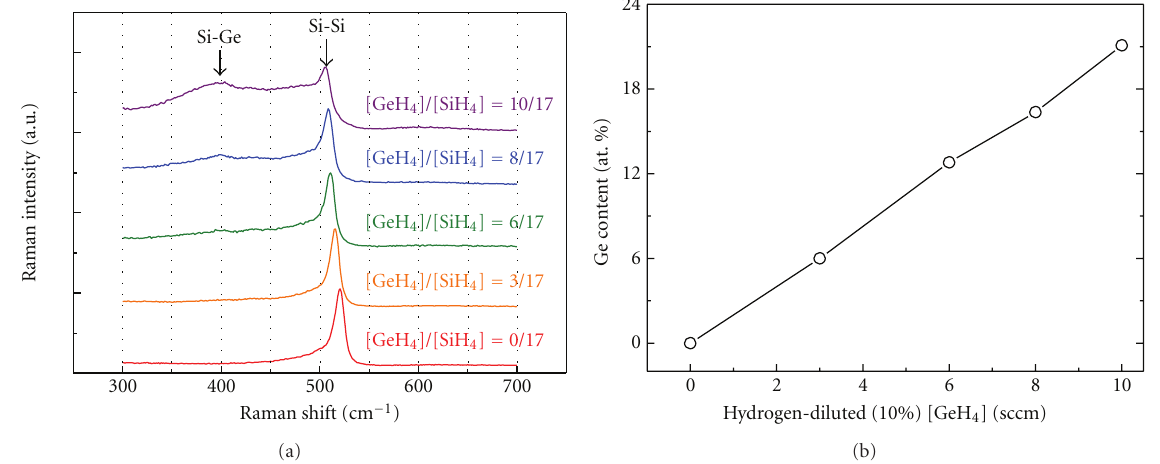
Figure 2: (a) Raman spectra of μ c-Si 1 − x Ge x :H films deposited at di ff erent [GeH 4 ]/[SiH 4 ] ratios. (b) The Ge content of μ c-Si 1 − x Ge x :H films deposited at di ff erent [GeH 4 ] estimated from Raman spectra.